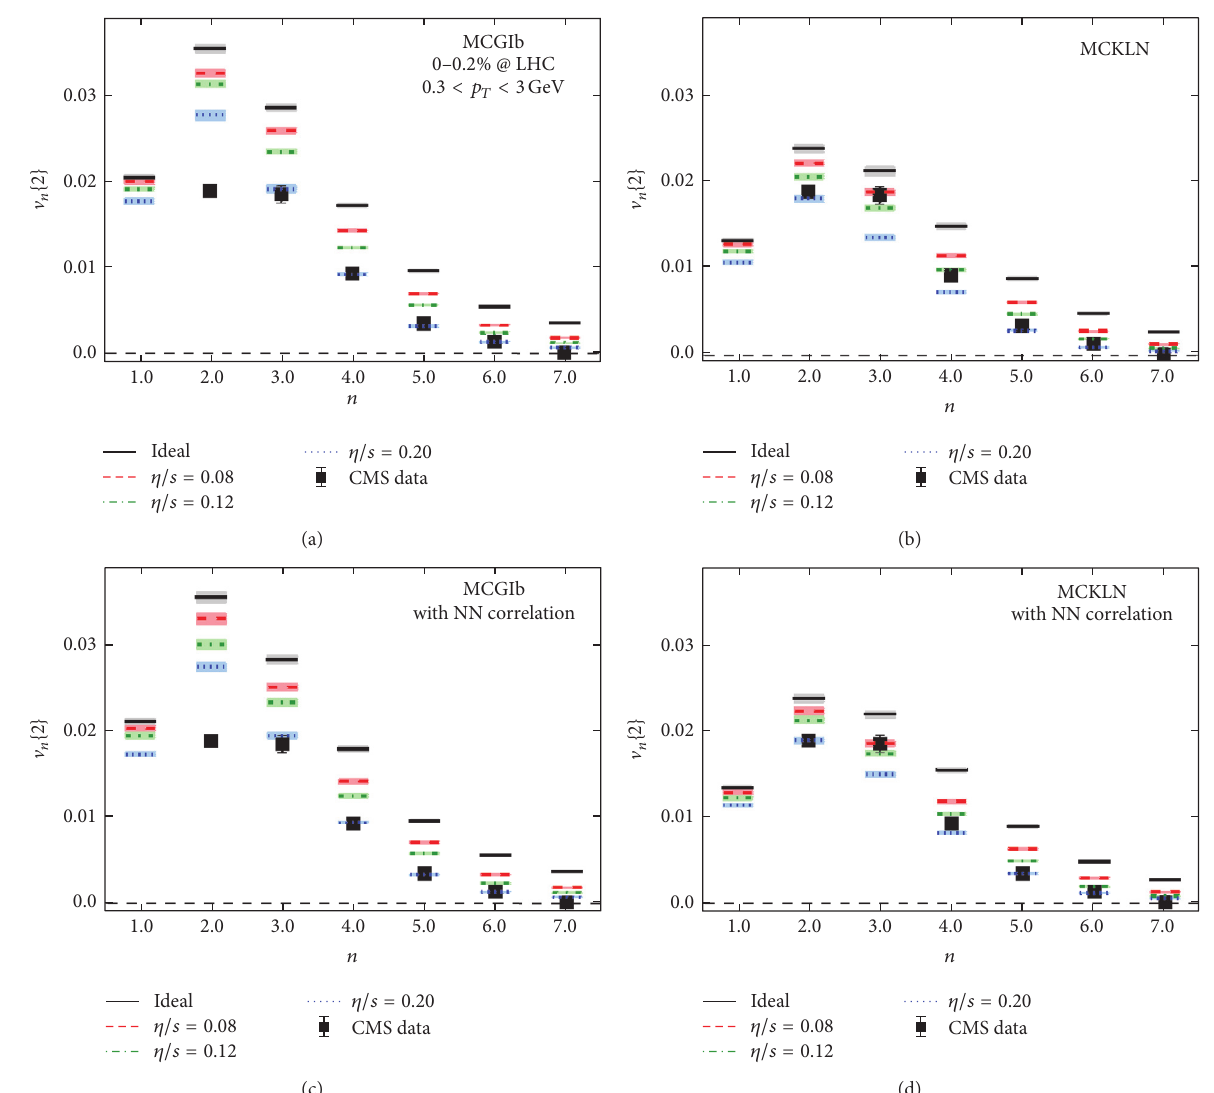
Figure 11: Comparison of 𝑝 𝑇 integrated V 𝑛 {2} of charged hadrons in 2.76 ATeV Pb+Pb collisions at 0–0.2% centrality for viscous hydrodynamics simulations (various lines) with the corresponding experimental results (solid squares). Plots (a) and (c) are for MC-Glauber initial conditions, and (b) and (d) correspond to MC-KLN initial conditions. Results in (a) and (b) were obtained by considering nucleons with a repulsive hard core, whereas the results in (c) and (d) are obtained for the initial conditions with finite nucleon-nucleon correlations. The figure is taken from